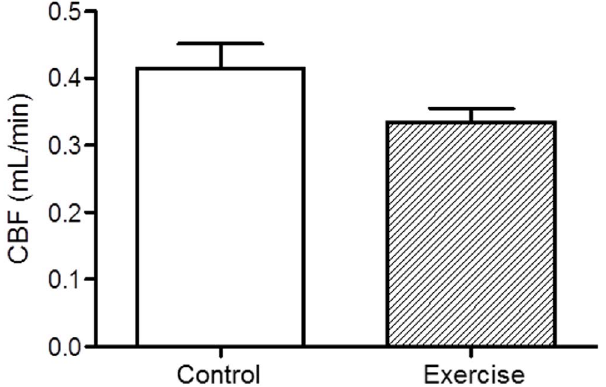
Figure 2. Steady state coronary blood flow. Coronary blood flow (CBF) was measured using echocardiography. Briefly, color flow Doppler was utilized to locate the left anterior descending coronary artery (LAD) and the pulsed wave Doppler sample volume was placed in line with the greatest flow. A modified apical 4-chamber view was used to obtain coronary flow velocities. As shown, there was no significant difference in CBF between the exercised and control groups (N 5 5/group).